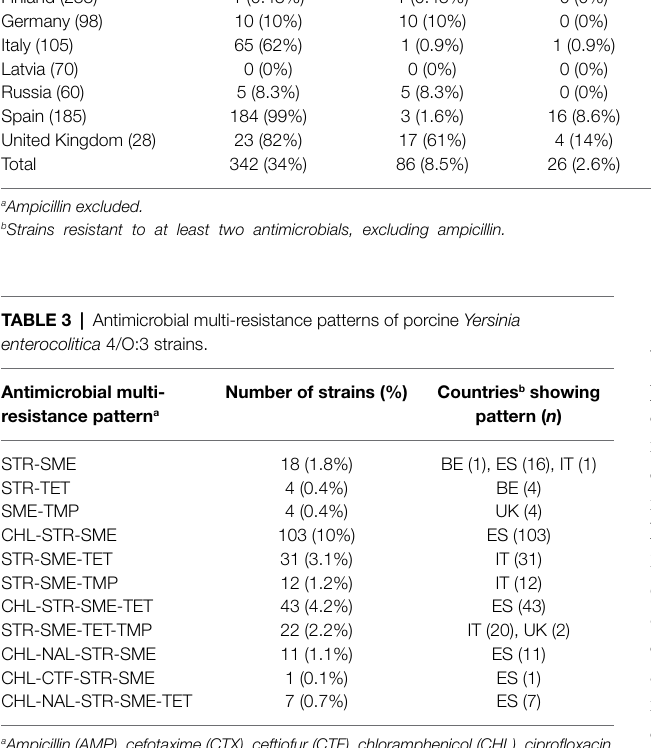
Number of strains n (%) resistant a to Total number of multiresistant b strains (%)One antimicrobial Two Three Four Five antimicrobials antimicrobials antimicrobials antimicrobials